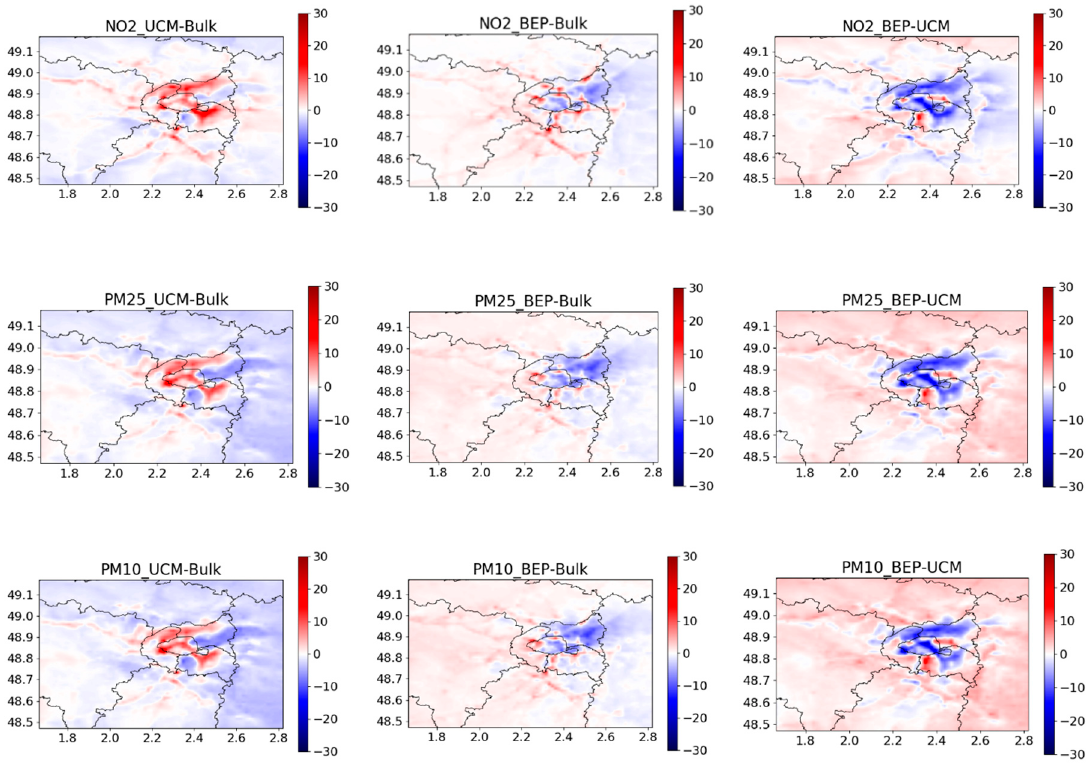
Figure 10. The differences in the daily averaged NO 2 (µg m − 3 ), PM 2.5 (µg m − 3 ), and PM 10 (µg m − 3 ) Figure 10. The di ff erences in the daily averaged NO 2 ( µ g m − 3 ), PM 2.5 ( µ g m − 3 ), and PM 10 ( µ g m − 3 ) between different schemes from 27th November to 4th December 2016. between di ff erent schemes from 27th November to 4th December 2016.